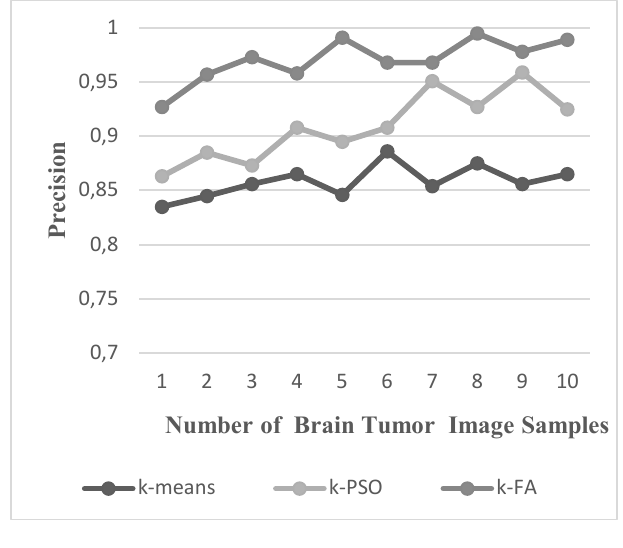
Figure 7 represents the comparison of precision results for k-means, k-means with PSO, and k-means with FA. In the graph, a number of brain tumor images is plotted on the X-axis against the parametric values of precision for all